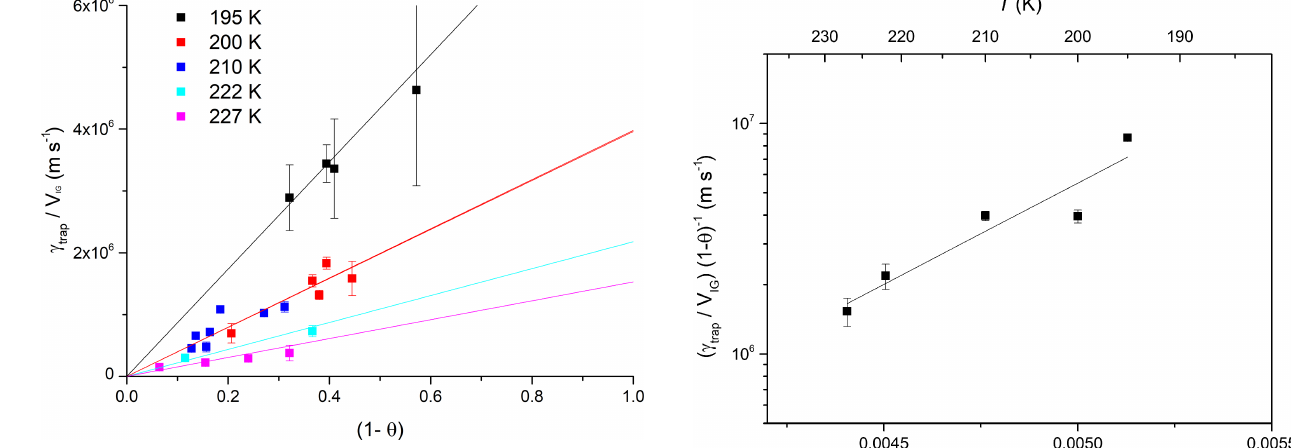
Figure 5. Plot of γ trap /V IG (as derived from data in Fig. 4) ver- sus (1- θ ) at different temperatures. The solid lines are proportional fits to the data at each temperature. The error bars represent total uncertainty.